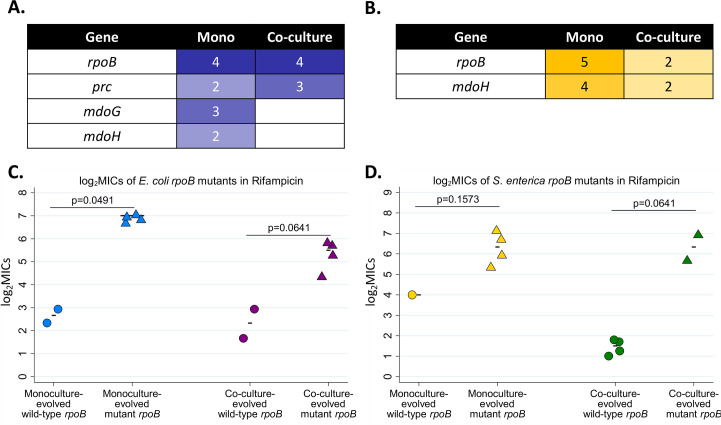
Resistance-associated mutations in rifampicin-resistant evolved populations A-B. Lists of mutations which arose in E. coli (A) or S. enterica (B) monocultures and co-cultures. The number in each box represents the number of independent replicates in which the putative resistance mutation was observed. Additional mutations that occurred in only one population, and details on the nature of these mutations, may be found in S1 Table. C-D. Rifampicin MICs for isolates with wild-type vs. mutant rpoB genes in E. coli (C) and S. enterica (D). Isolates were obtained from passage 20 populations by streaking onto selective medium and picking isolated colonies. Each data point represents the average MIC for three isolates obtained from a single population. For each species- culture type combination, there are six populations total, and the statistical comparisons represent MIC comparisons between populations with wild type vs. mutant alleles. Note that there are only five S. enterica monoculture populations due to possible contamination in one population. MIC90 values for isolates were defined as the lowest concentration of antibiotic which decreased growth by greater than 90% by 48 hours at 30°C. Additionally, monoculture lines evolved more mutations than co-culture lines. Mutations in mdoG and mdoH were observed in both monocultures of E. coli and S. enterica under rifampicin selection, but at much lower frequencies in co-culture (S1 Table, S2 Fig). All but one of these mutations were insertions or deletions of 1-6bp causing frameshift mutations (S1 Table). Both mdoG and mdoH likely influence cell membrane permeability [31,32]. The mutations were not associated with any changes in monoculture or co-culture growth rates (S3 Fig). Taken together, the pattern of rifampicin resistance mutations suggests that populations were moving along the same evolutionary trajectory in monoculture and co-culture, but progressed further along that trajectory in monocultures.